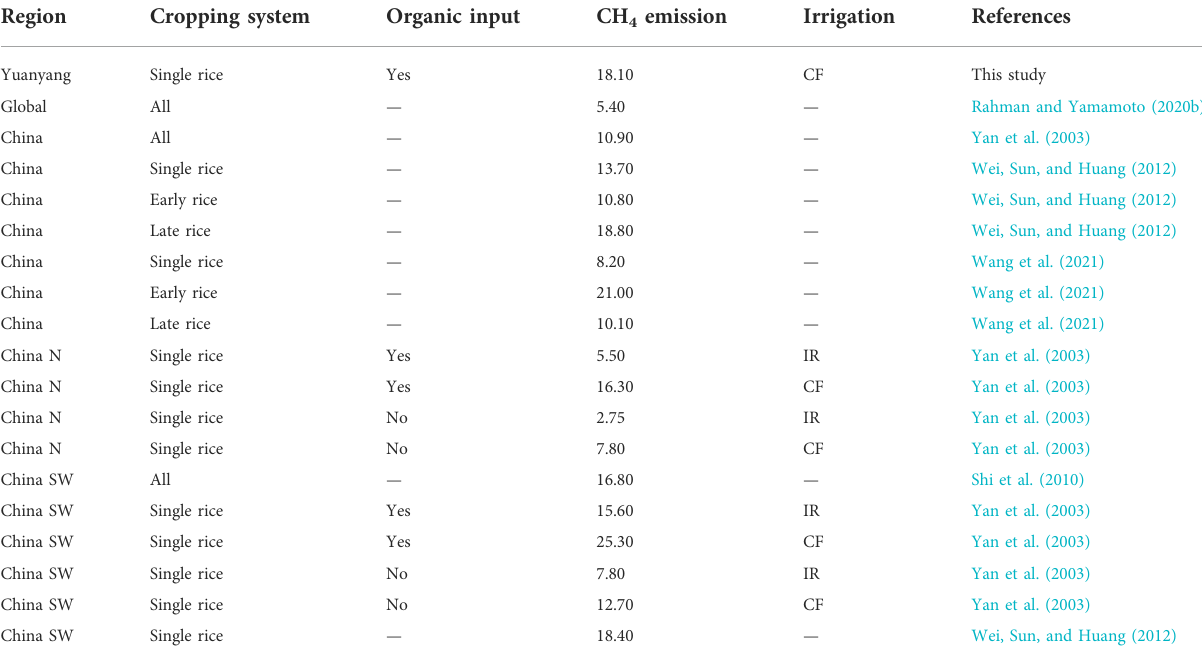
TABLE 2 Region-Speci fi c CH 4 Emission Factors (mean value, mg/m 2